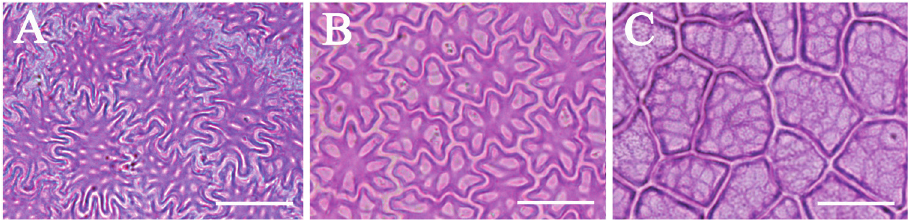
Figure 3 . Leaf epidermal micromorphology of Cinnamomum , displaying the Type II upper leaf epider- mis with irregular or polygonal cell shape, reticulate periclinal walls, and straight, sinuous to extremely sinuous anticlinal walls A C. iners B C. appelianum C C. pittosporoides . Scale bars: 20 μm.